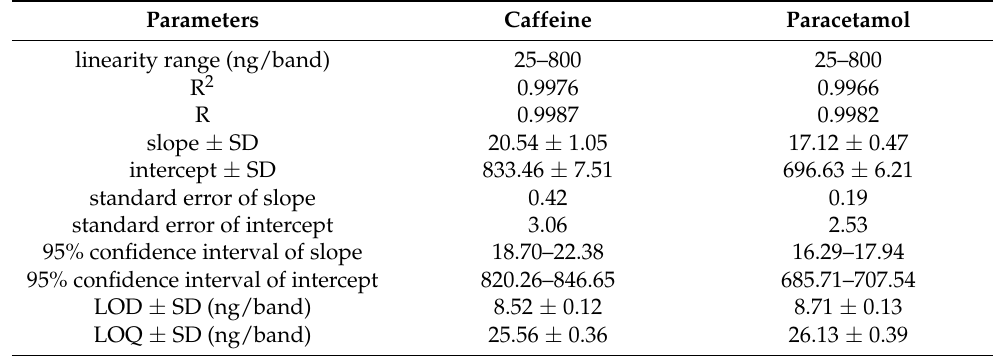
Table 2. Results for linear regression analysis for the SMD of caffeine and paracetamol using the greener reversed-phase HPTLC method (mean ± SD; n =